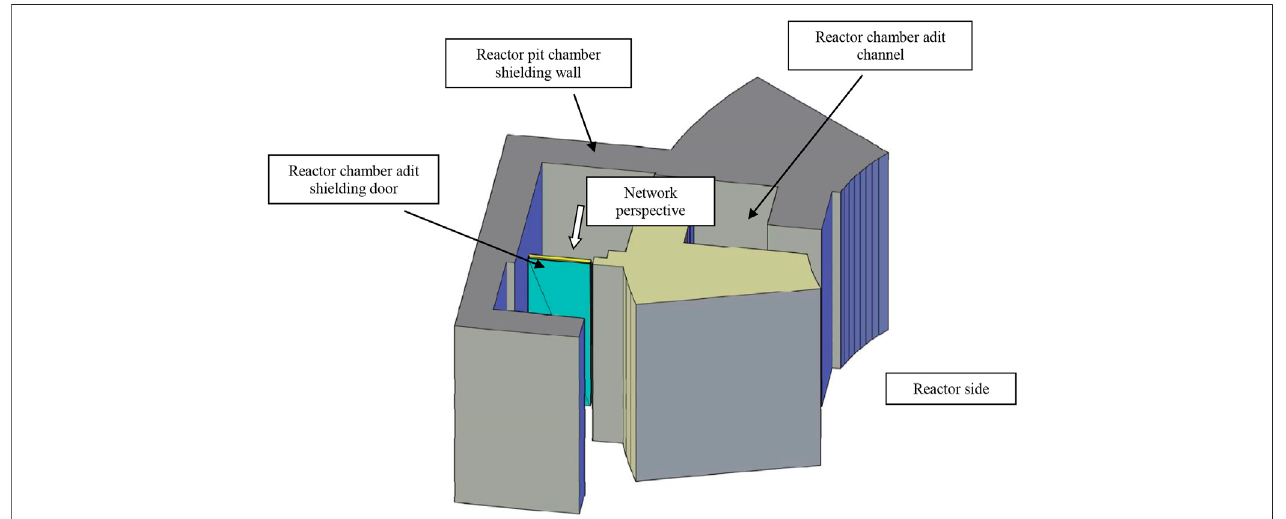
FIGURE 5 | MCNP calculation simpli fi ed model for the shielding door of the reactor pit chamber.